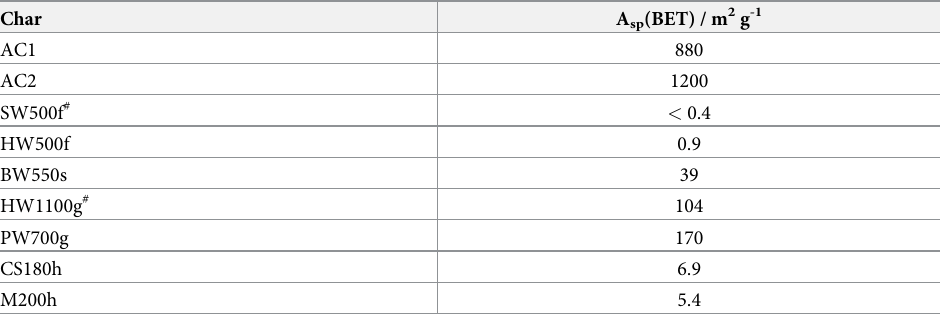
Table 1. Specific surface area determined by